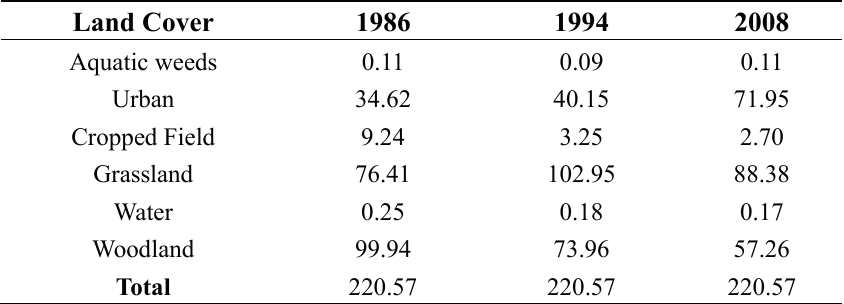
Table 9. Land conversions in square kilometers for Marimba catchment for the period 1986–2008.